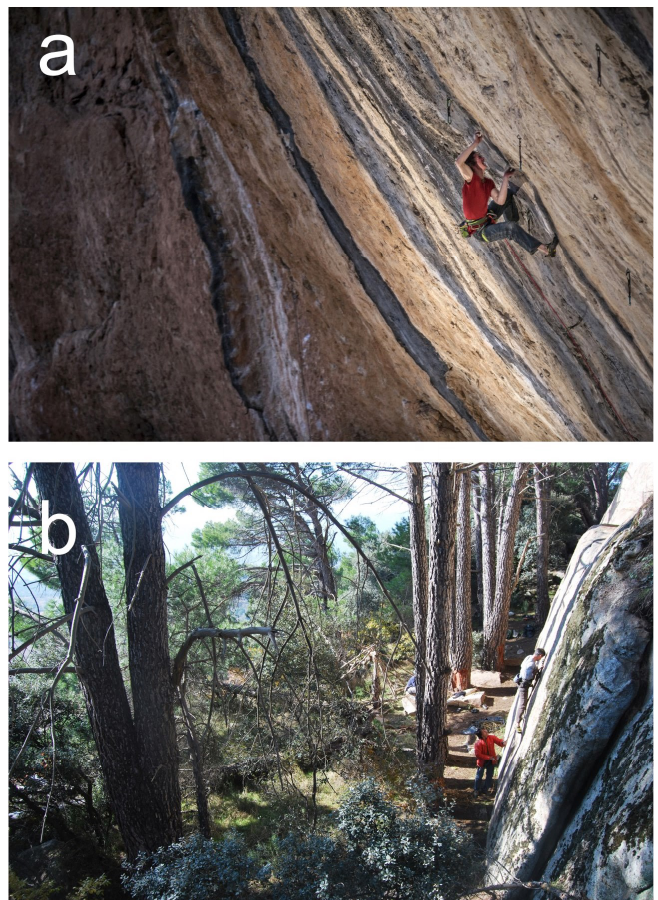
Figure 1. Photographs of selected climbing areas with recent wildfires: ( a ) Oliana site (Catalonia region), with the iconic route La Dura Dura, the first 9b+ in the world achieved by world-class Czech climber Adam Ondra (Image by Bernardo Gim é nez); ( b ) forested area of Cadalso de los Vidrios (Madrid region) near Madrid